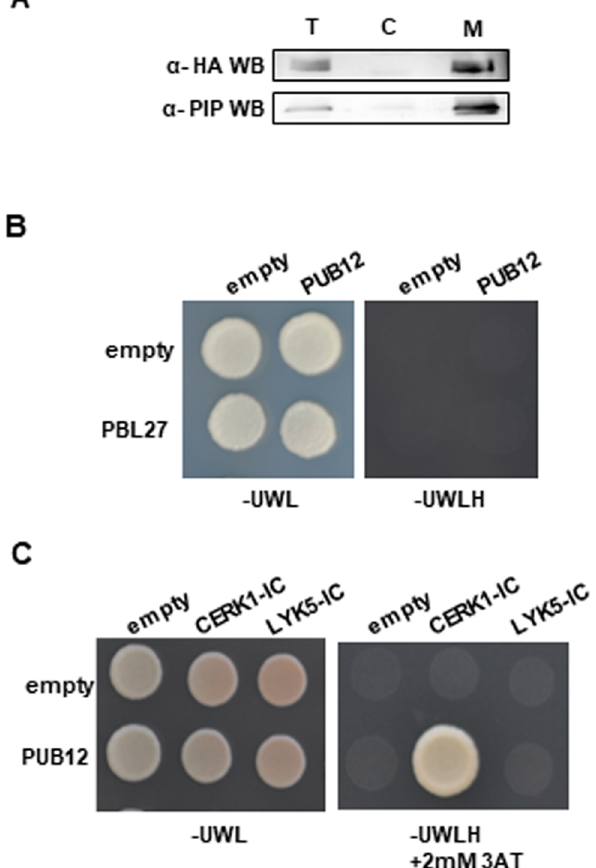
Fig 1. Identification of PUB12 in the PBL27 complex. (A) The PBL27-3HAprotein was detected in the membranefraction. The total (T), soluble(S), and microsomalmembrane(M) fractions purifiedfrom Arabidopsis seedlingsexpressingPBL27-3HAwere used in immunoblots with α -HA. (B) PBL27 does not interact with PUB12 in the yeast two hybrid experiment. The growth of yeast colonieson the plate. (C) PUB12 interacts with the intracellulardomain(IC) of CERK1, but not LYK5 in the yeast two hybridexperiment. The growth of yeast colonieson plates (-ULWH) lackinguracil (U), leucine(L), tryptophan (W), and histidine(H) with 2 mM 3-aminotriazole (3-AT) indicatesa positive